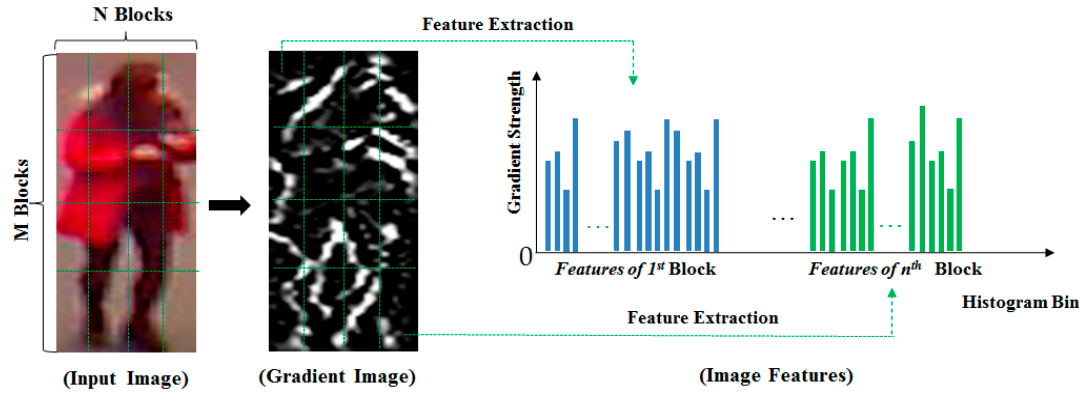
Figure 3. HOG image features formation from a human body image.